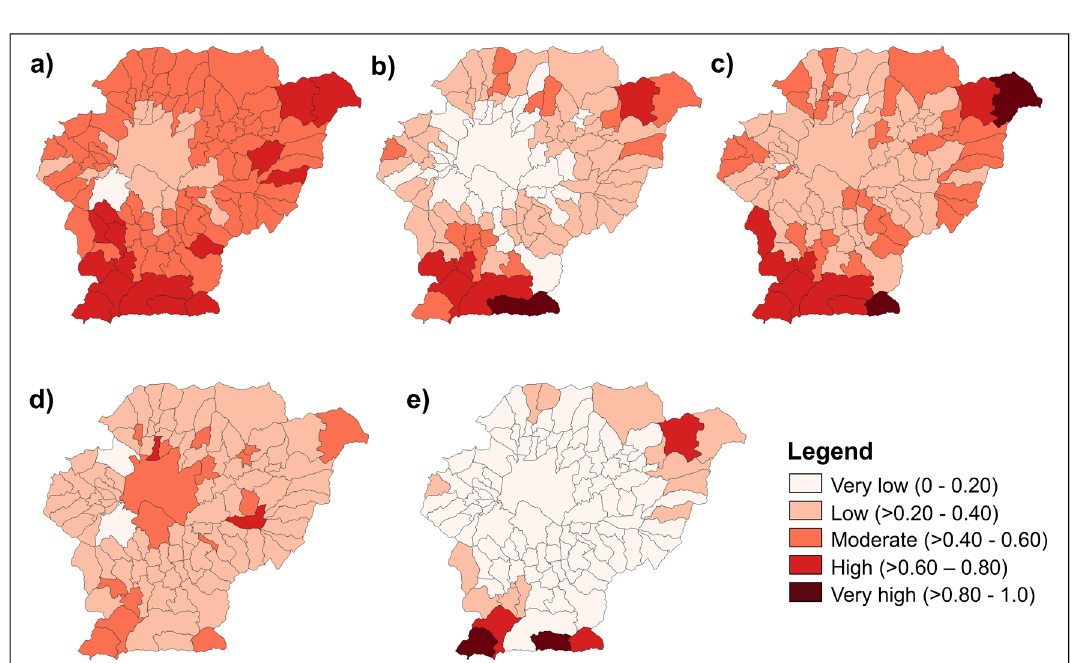
Figure 7. Social vulnerability score per indicator ( I n ) : ( a ) Population; ( b ) Education; ( c ) Economy; ( d ) Habitat; and ( e ) ranks. As shown in the map, the level of social vulnerability is not uniform. Most locations in the central, less elevated part of the valley have very low or low vulnerability. In contrast, many areas on the borders (especially the southern and north-eastern parts) have very high or high vulnerability. Figure 7 illustrates the social vul- nerability per indicator (i.e., the I n value computed in Step 2 from SoVI calculation). Population, Economy and Habitat are the vulnerability indicators that exhibit the lowest variability, with coefficients of variation of 20%,